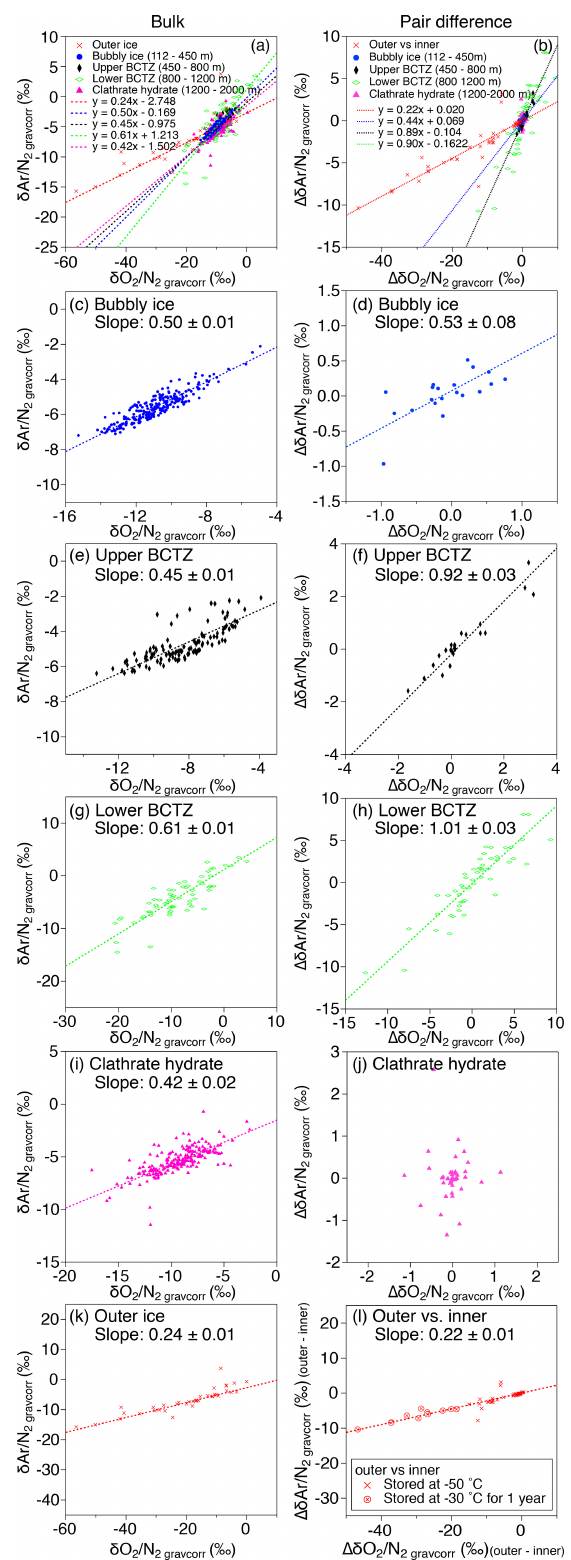
Figure 10. Scatter plot of δ O 2 / N 2gravcorr vs. δ Ar / N 2gravcorr (a, c, e, g, i, k) and that of pair differences of δ O 2 / N 2gravcorr and δ Ar / N 2gravcorr (b, d, f, h, j, l) . (a, b) All data, (c, d) bubbly ice zone (112–450m), (e, f) upper BCTZ (450–800m), (g, h) lower